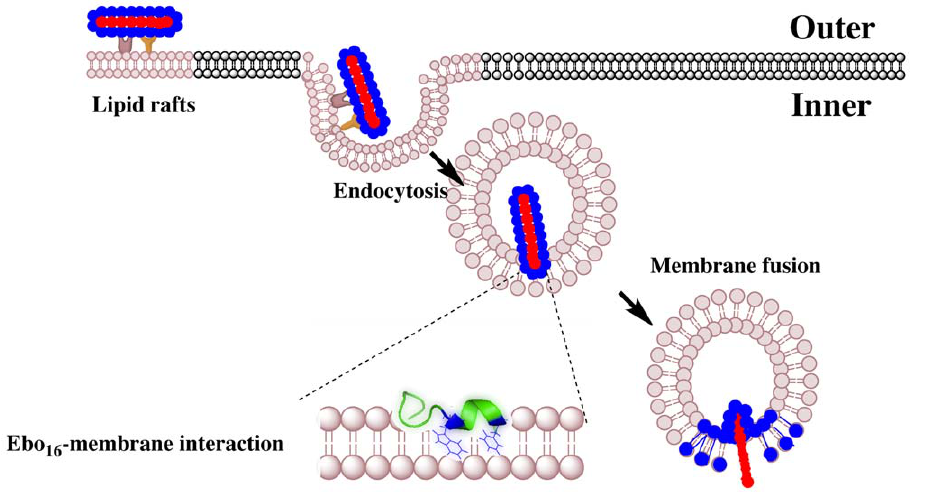
Figure 7. Schematic view of Ebola virus entry and fusion promoted by the fusion domain (EBO 16 ). The interaction between Trp8 and Phe12 is emphasized with the tridimensional structure of EBO 16 immersed in the lipid membrane (from PDB entry 2RLJ, [12]).